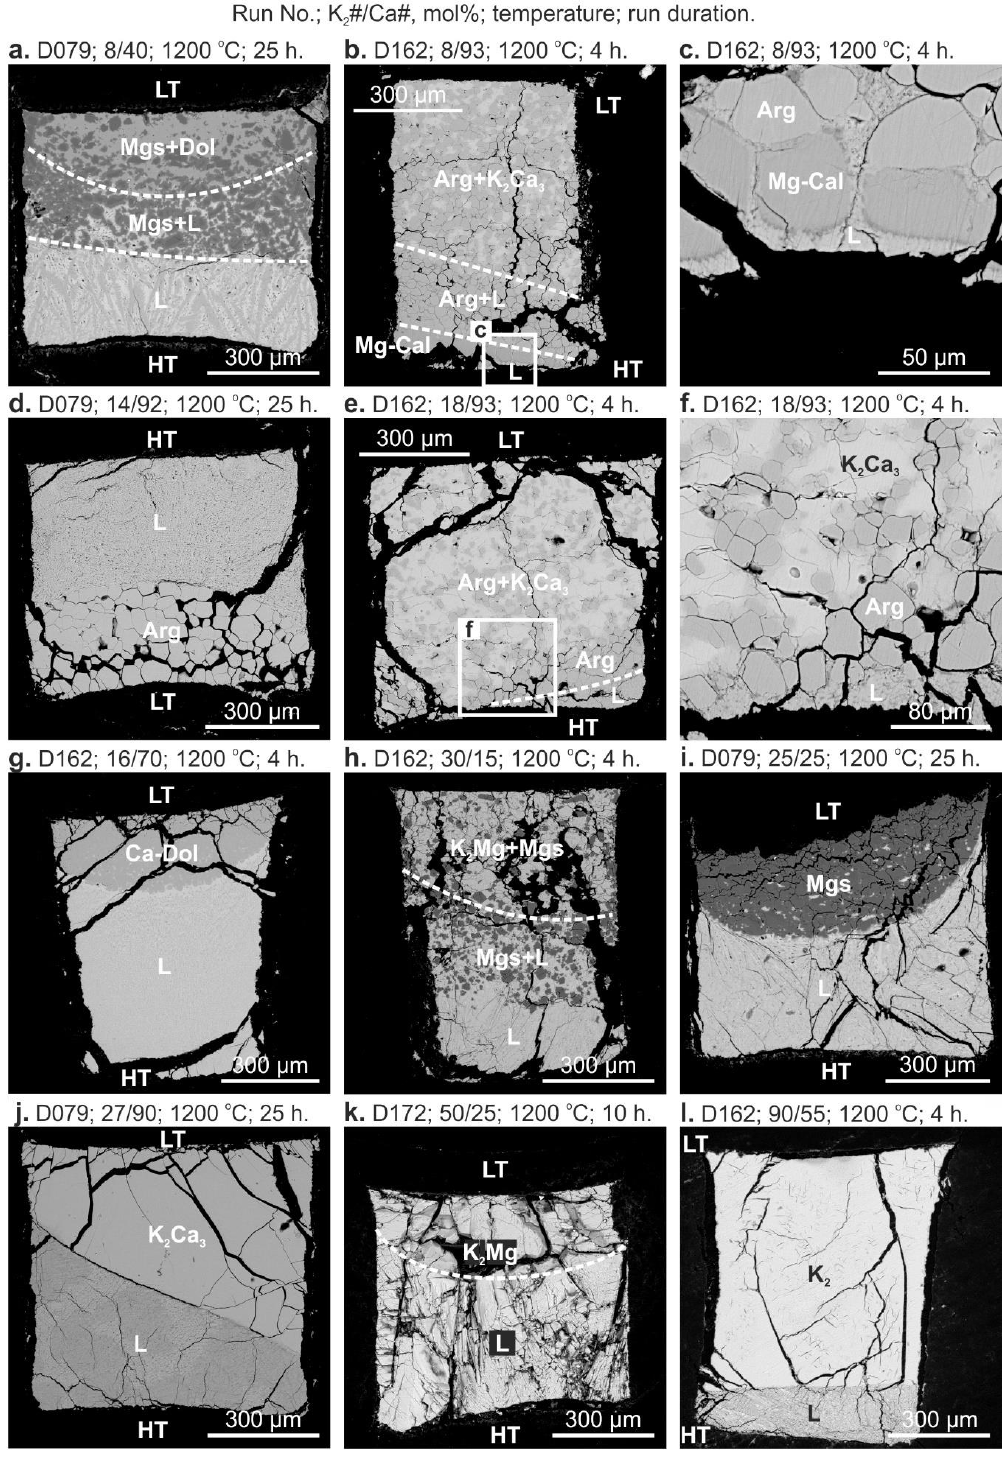
Figure 3. BSE images of sample cross-sections illustrating phase relationships in the system K 2 CO 3 −CaCO 3 – MgCO 3 at 6 GPa and 1200 °C. K 2 #/Ca# indicates bulk compositions of the starting mixtures, K 2 # = 100∙K 2 CO 3 /(K 2 CO 3 + CaCO 3 + MgCO 3 ), Ca# =100∙CaCO 3 /(CaCO 3 + MgCO 3 ). LT — low- temperature side. HT — high-temperature side. See the Nomenclature section for abbreviations.